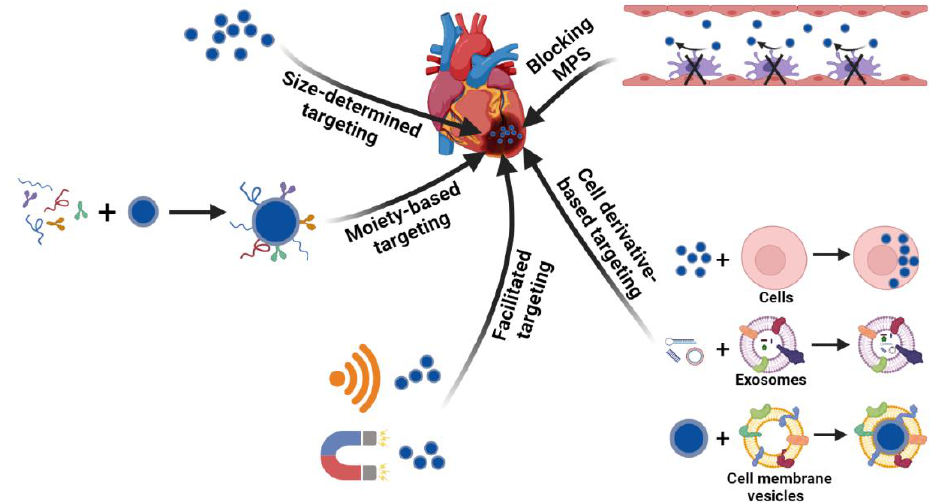
Figure 2. Targeting strategies of non-viral delivery systems for an injured heart.